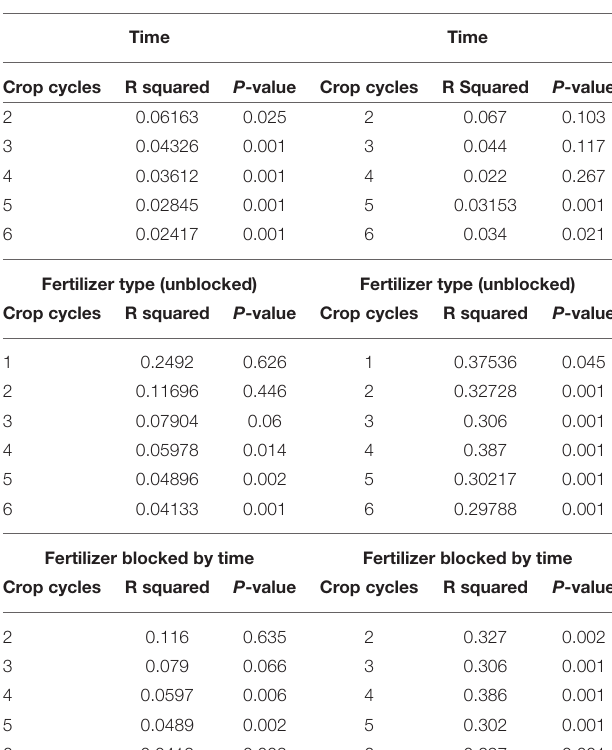
TABLE 2 | PERMANOVA comparison of community differences across cropping cycles for prokaryotes and fungi. Prokaryotes